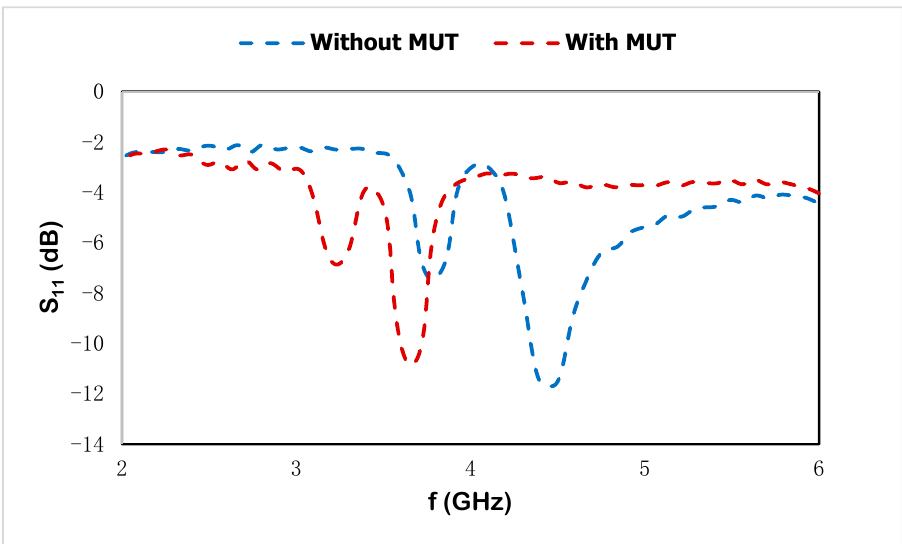
Figure 15. Measured results with MUT and without MUT.